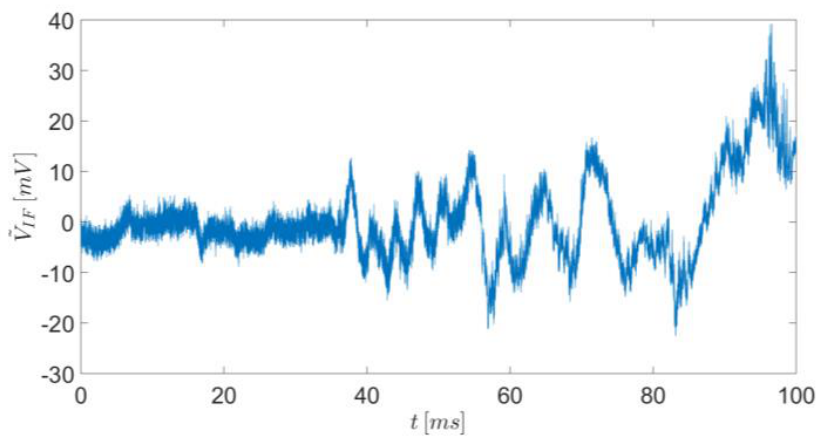
Figure 5. Measurement results of the intermediate frequency signal in the time domain.